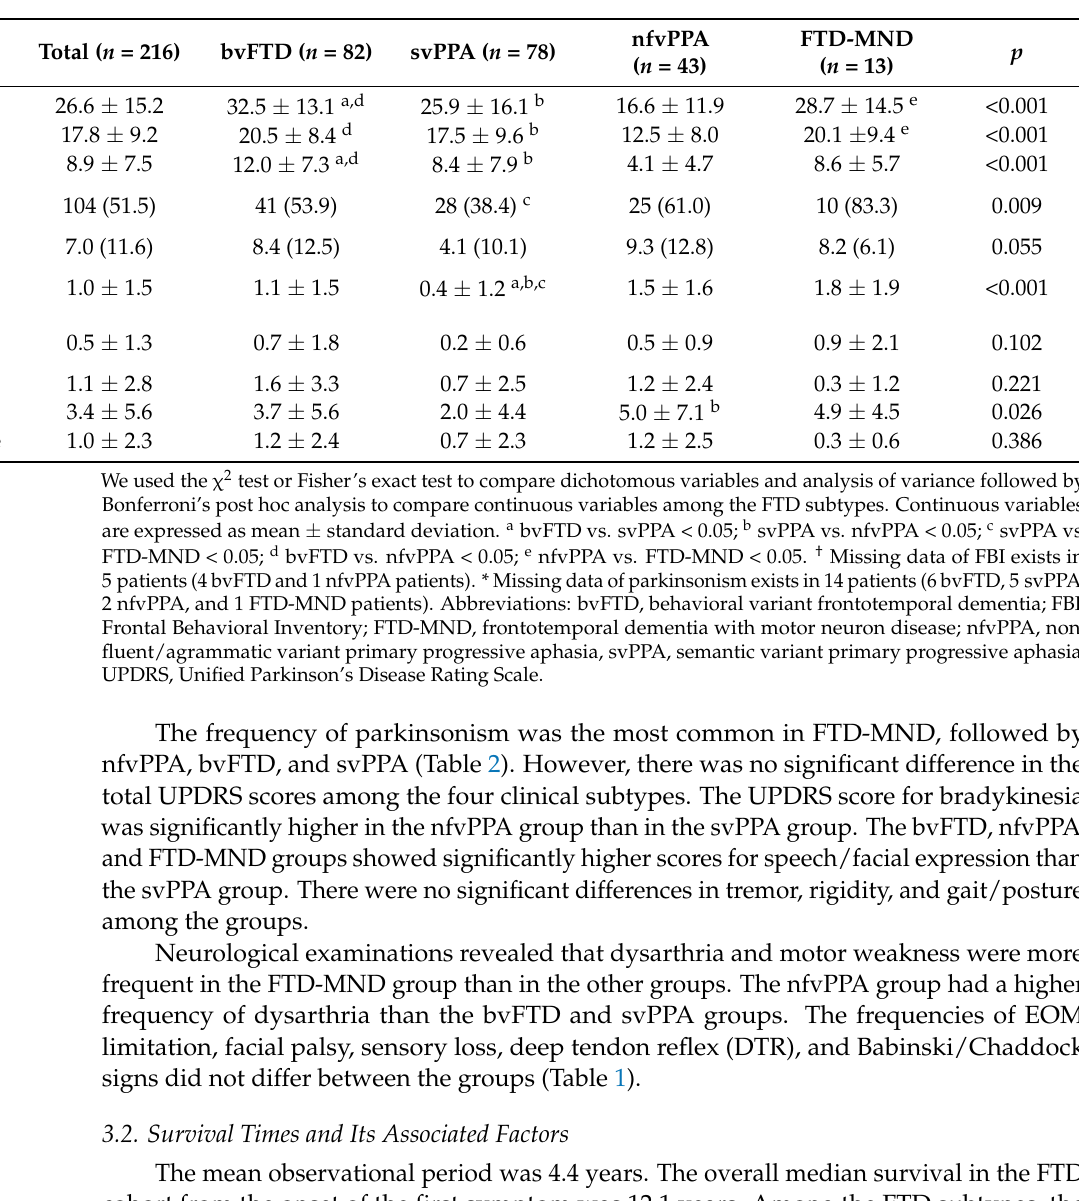
Table 2. Behavioral and parkinsonian